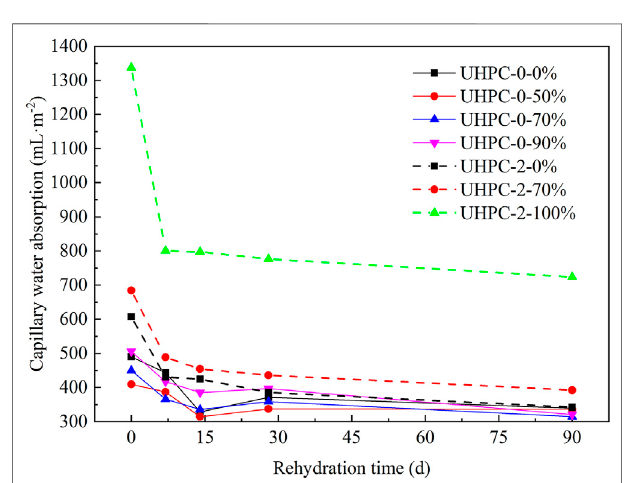
FIGURE 9 | Cumulative capillary water absorption of UHPC-0 and UHPC-2 with increasing rehydration time.